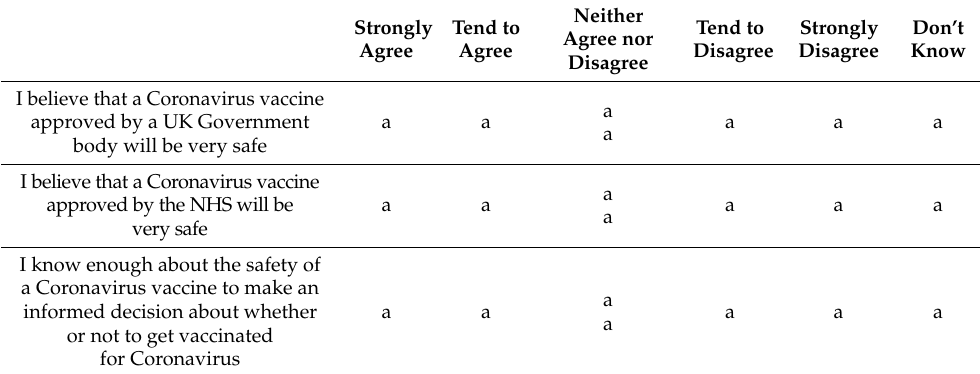
Table A4. To what extent do you agree or disagree with the following statements about vaccines? (please select one option only in each